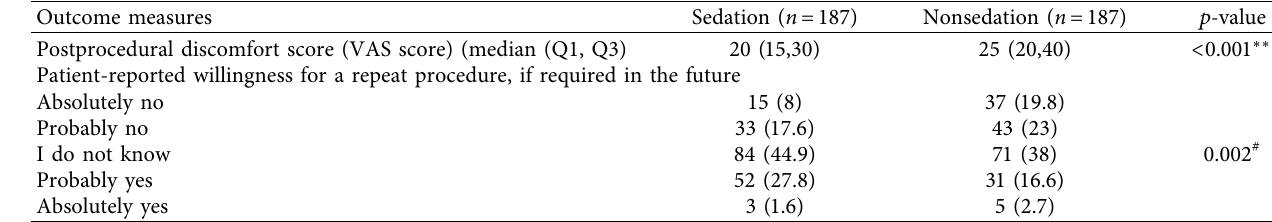
Table 2: Postflexible bronchoscopy outcome